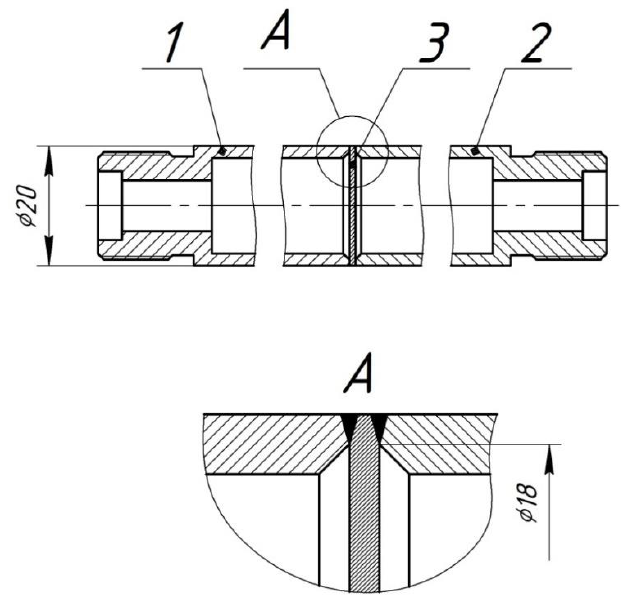
Figure 3. Permeability testing system: PS1, PS2, PS3—pressure sensors; HV—hand valve; AV1, AV2—air valve; H1—heater; ST—surge tank; QMS—mass spectrometer; TP—turbomolecular pump; BP—backing pump; hydrogen supply—vanadium metal hydride hydrogen generator.